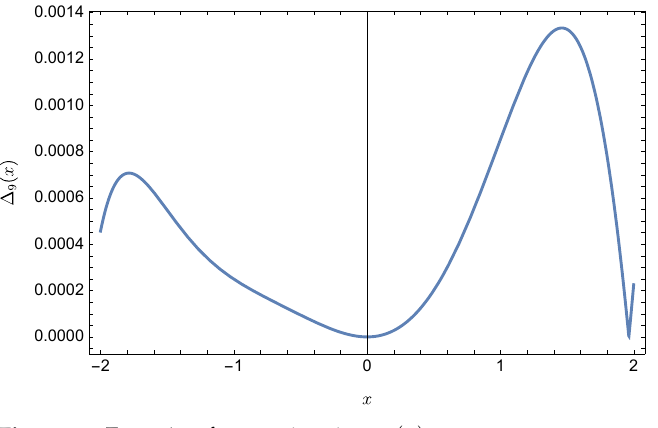
Figure 12. Error ∆ 9 of approximation y 9 ( x )